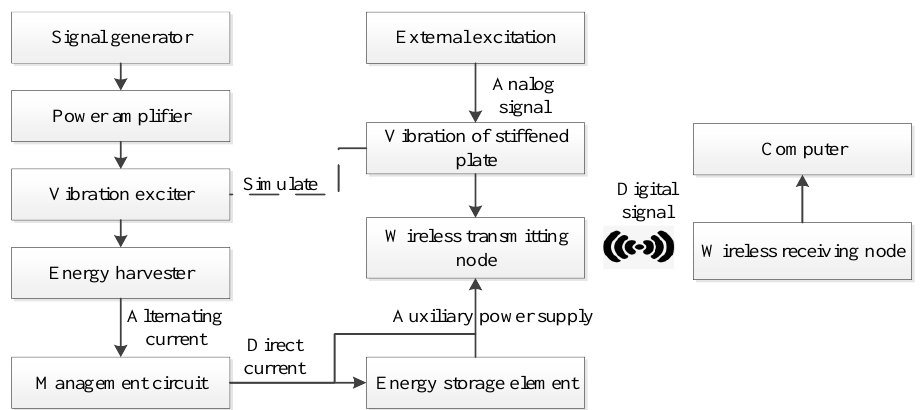
Figure 23. Experimental flow chart of auxiliary power supply for wireless transmission module.